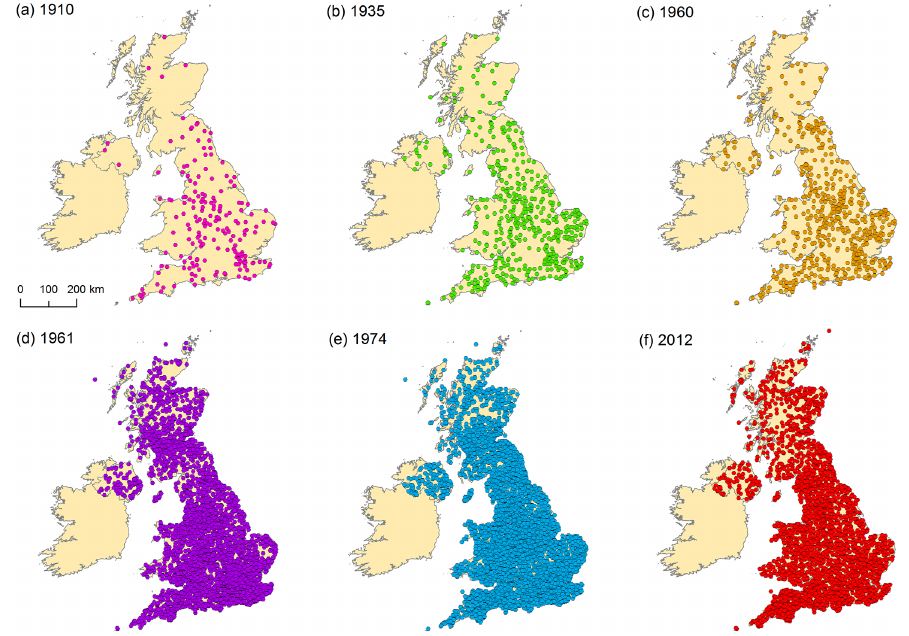
Figure 3. Maps of daily rain gauges used to derive CEH-GEAR rainfall grids on 1 January (a) 1910, (b) 1935, (c) 1960, (d) 1961, (e) 1974 and (f)